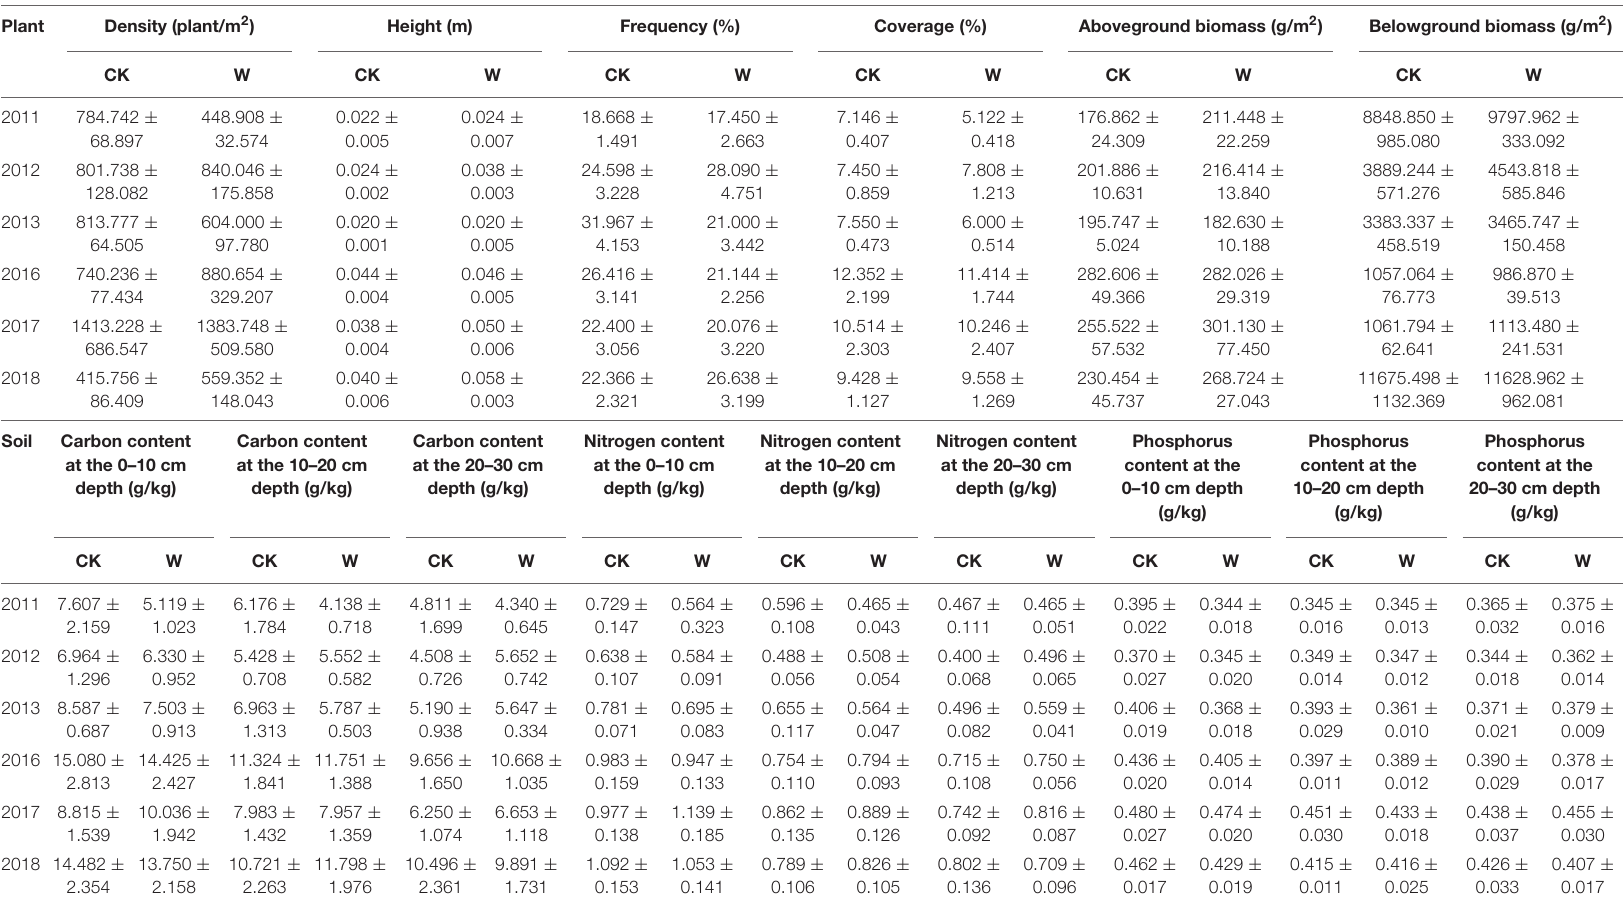
The data are shown by mean ± standard